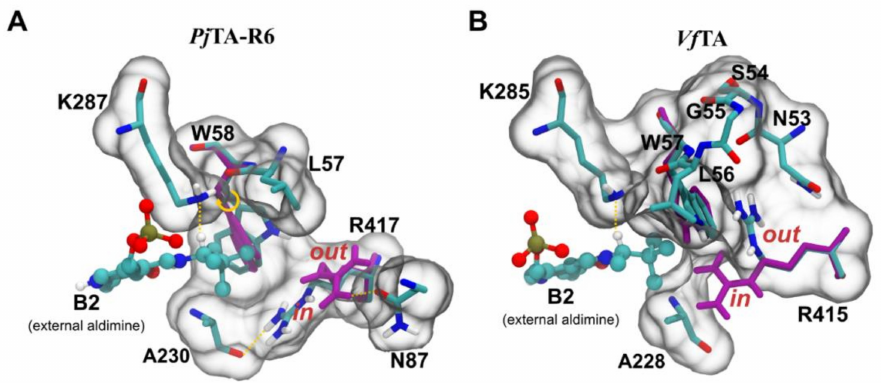
Figure 3. Docked external aldimine structures of 3,3-dimethyl-2-butylamine B2 , representative of a products with bulky substituents. ( A ) In Pj TA-R6, the tert -butyl substituent can be easily accommodated in the large pocket by a 40 ◦ rotation of Trp58 (yellow arrow). Arg417 does not induce protein–ligand clashes in either the “in” or the “out” orientation. ( B ) In Vf TA, both the “in” and the “out” conformations of Arg415 prevent a rotation of Trp57 necessary to accommodate the tert -butyl substituent. In both panels, protein structures are shown in licorice representation, and the crystal structure conformations of residues Arg417 / Arg415 and Trp58 / Trp57 are colored magenta (PDBs 4Q3H for Vf TA and 6TB1 for Pj TA-R6). The external aldimine structure of B2 is shown in CPK representation. Figures were rendered using VMD (Visual Molecular